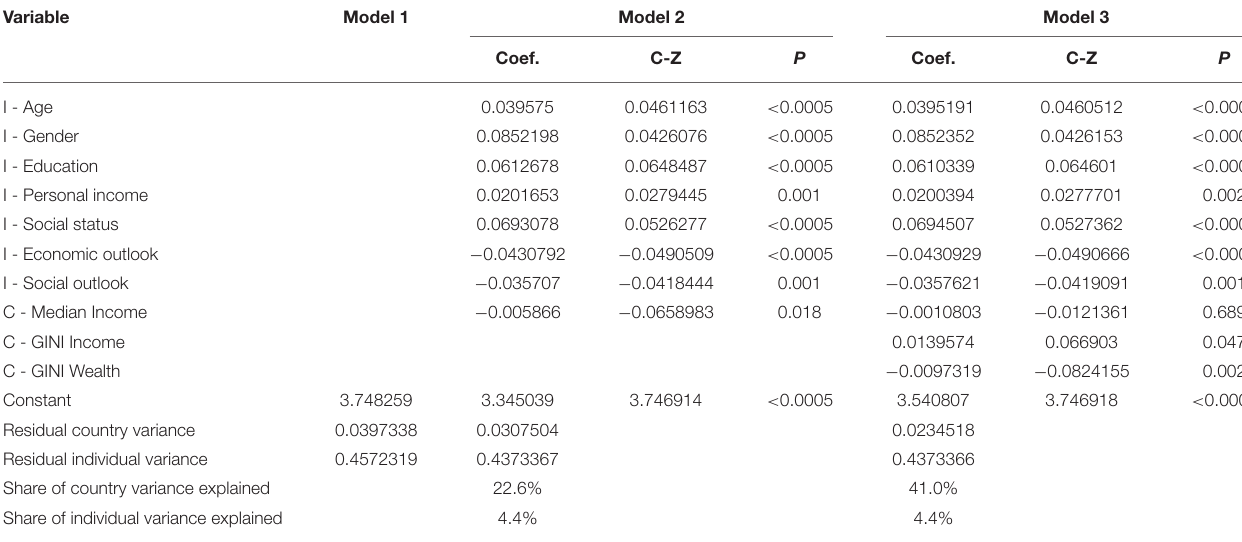
TABLE 5 | Multilevel regression on the sustainable energy caring index (SECI).